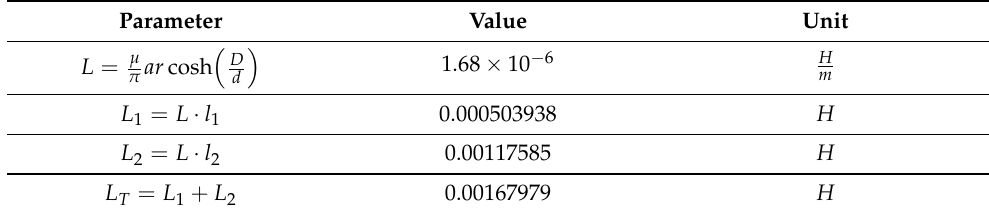
Table A5. Transmission line inductance.